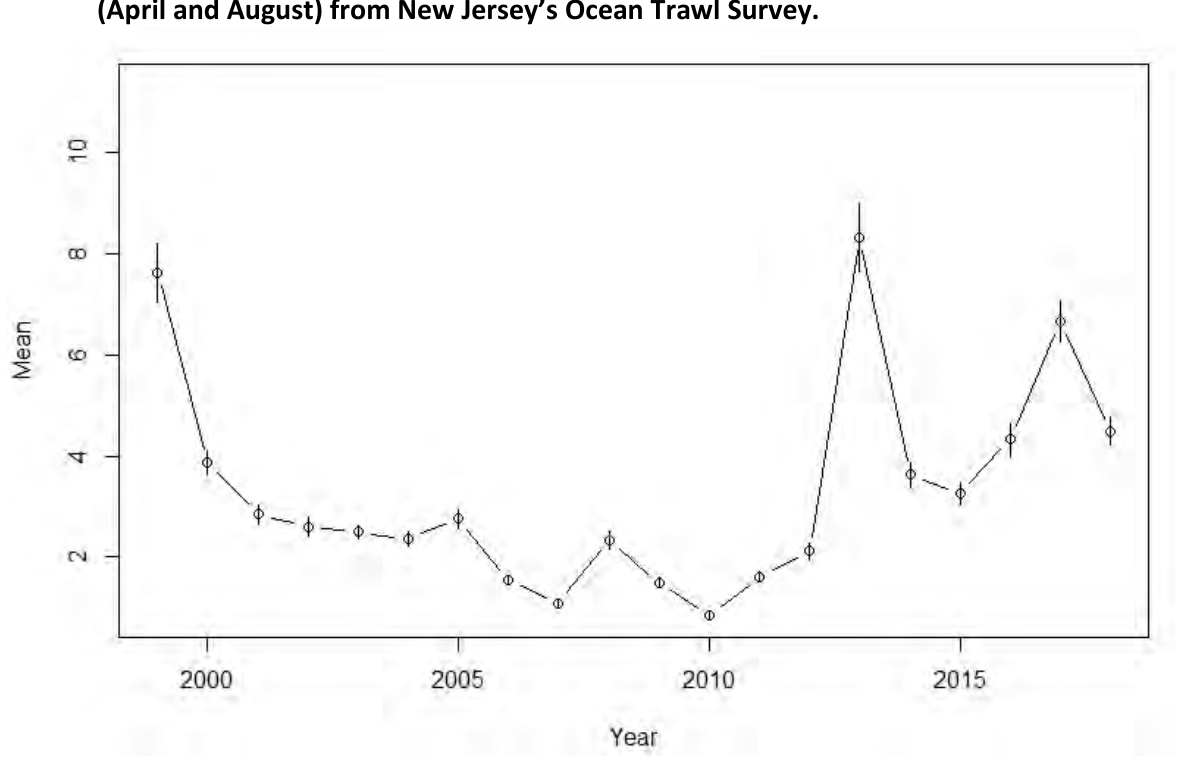
Figure 46. Abundance index for adult male horseshoe crabs in the spring (April and August) from New Jersey’s Ocean Trawl